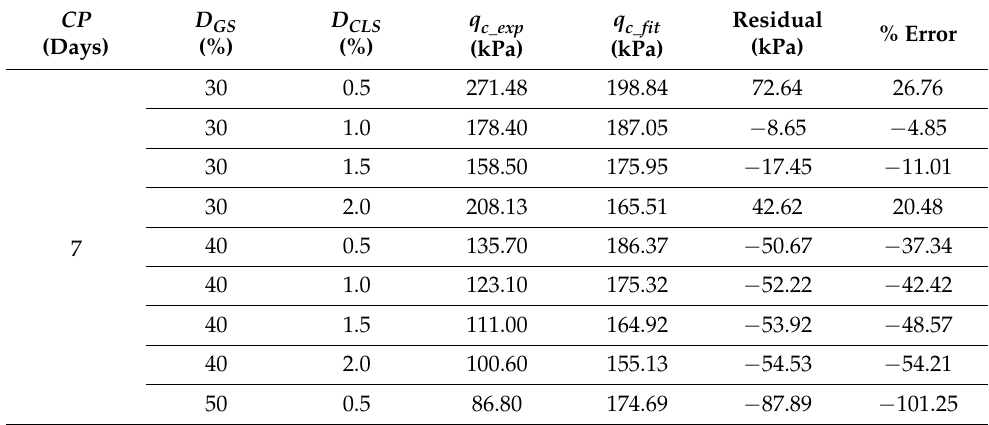
Table 7. The nonlinear equation for the UCS ( q c _ fit ) of treated soil with granite sand (GS) and calcium lignosulphonate (CLS) measured after 7 and 14 days of